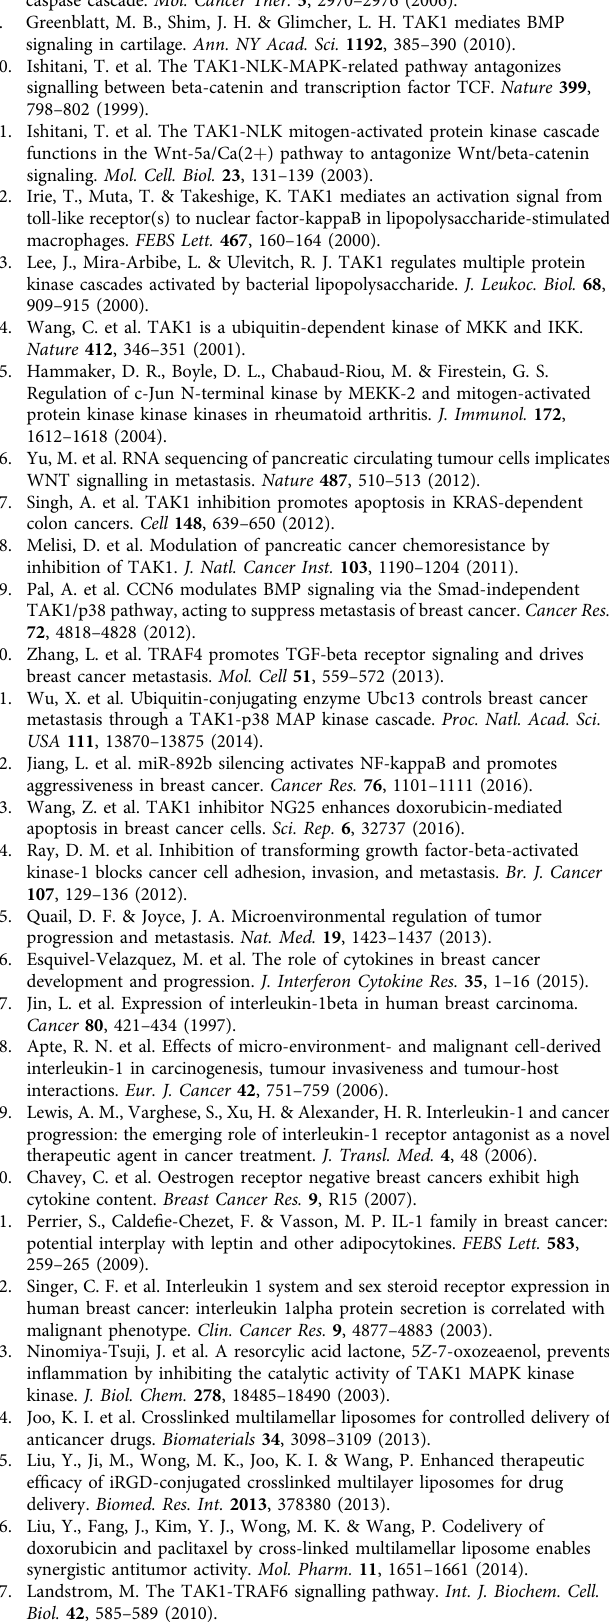
Supplementary Table 2, respectively. Uncropped versions of western blots from main fi gures are shown in Supplementary Fig. 6.